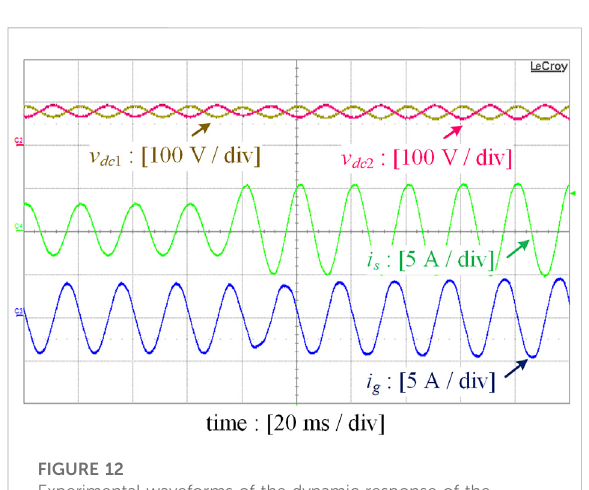
FIGURE 12 Experimental waveforms of the dynamic response of the proposed half-bridge